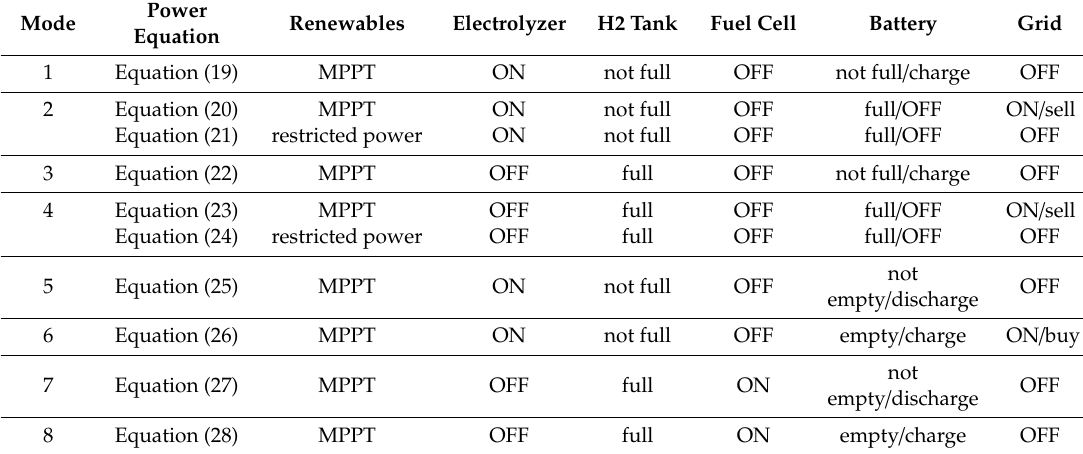
Table 2. Summary of operation